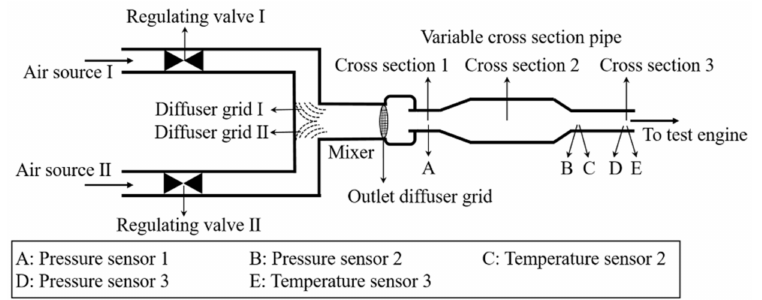
Figure 11. Schematic diagram of Flight Environment Simulation System.